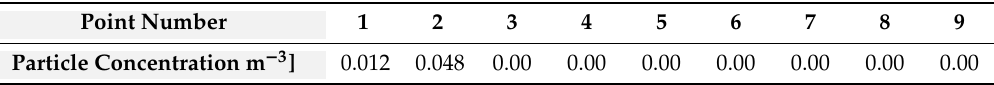
Table 3. Particle concentration in the reference points of simulation 10-235-10.